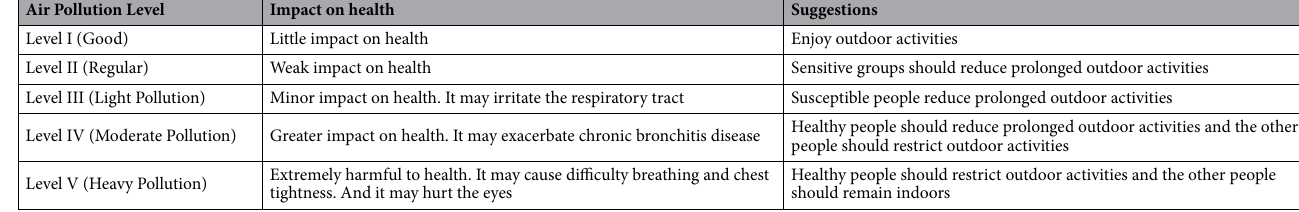
Table 3. Description of air quality